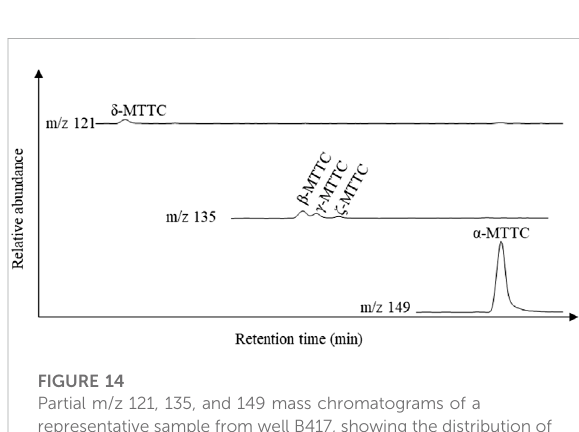
FIGURE 14 Partial m/z 121, 135, and 149 mass chromatograms of